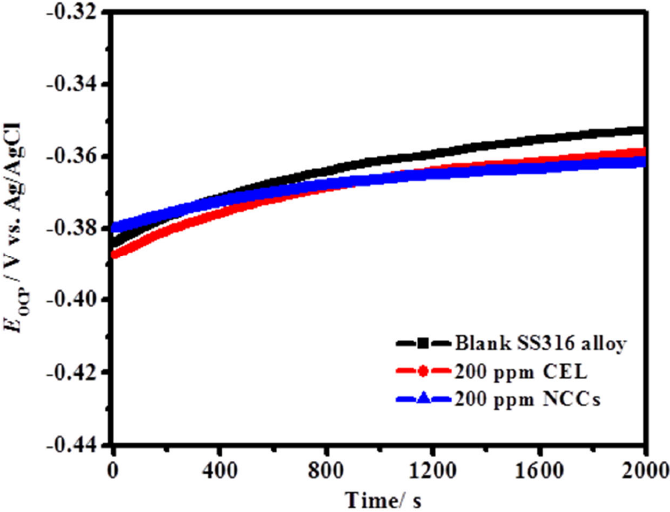
Figure 6. Fruition of the OCP versus time for SS316 alloy in 2.0 M HCl at the maximum-tested dose of (200 ppm) CEL and NCC at 323 K.